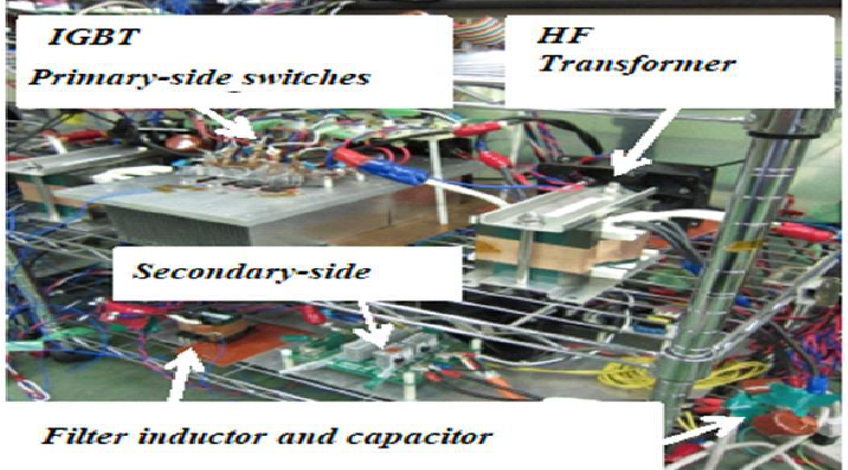
Figure 9. The exterior appearance of laboratory setup of the studied DC–DC power converter.